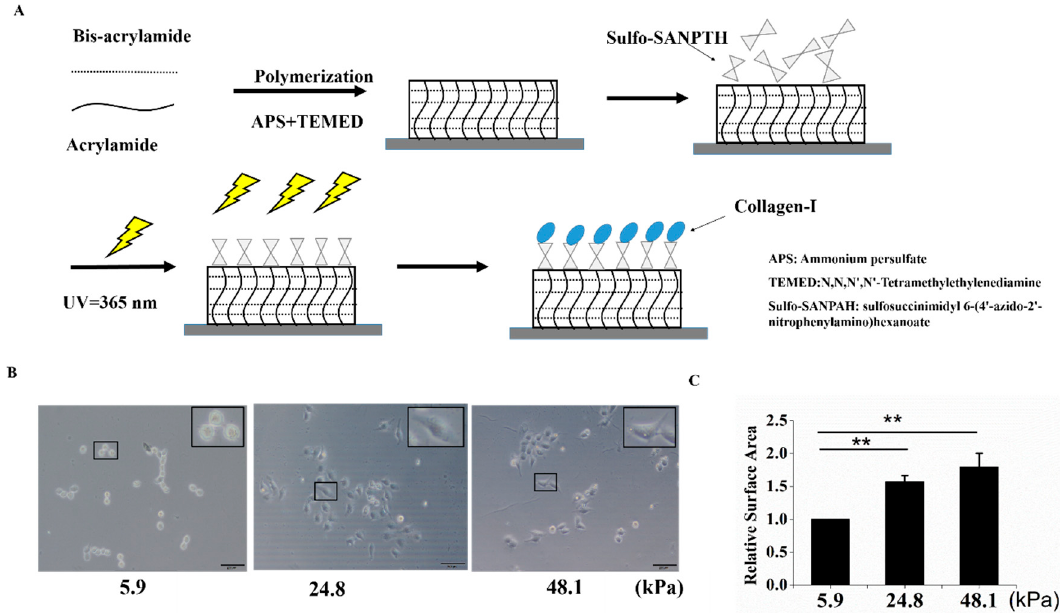
Figure 1. A schematic of polyacrylamide (PA) hydrogel preparation and cell seeding. ( A ) A schematic of PA hydrogel crosslinking and coating. ( B , C ) The stiff matrix induced cell spreading, and relative cell spreading area statistics are shown. Bar = 200 μm . The values are presented as the mean ± standard deviation (SD) of three independent experiments. n = 3; and ** p < 0.01.